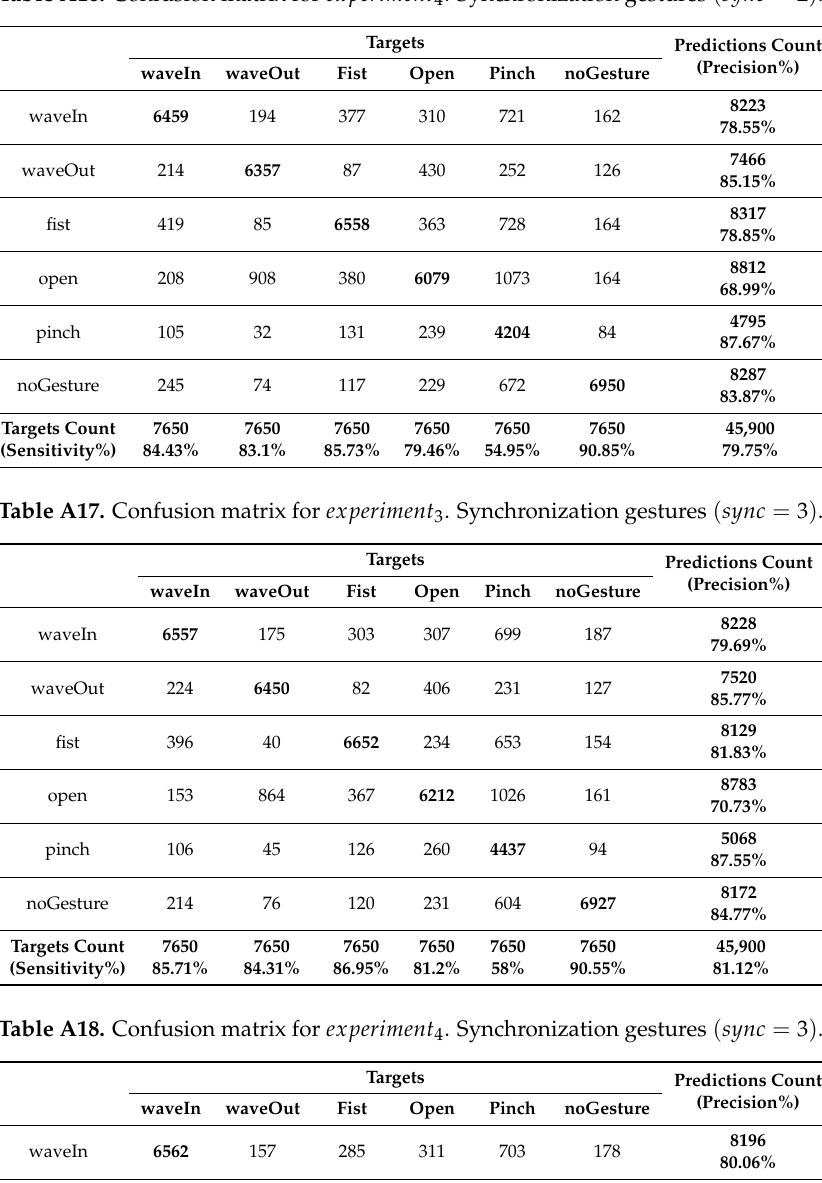
Table A16. Confusion matrix for experiment 4 . Synchronization gestures ( sync = 2 ) .